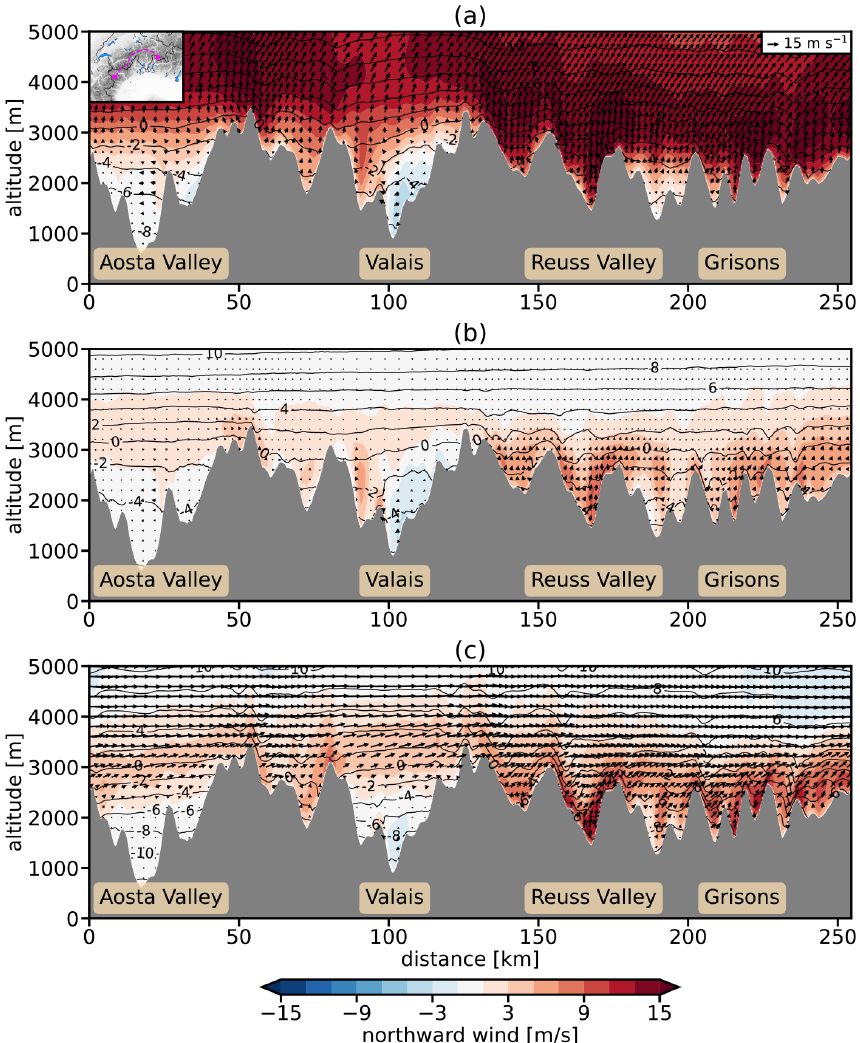
Figure 5. Same as Fig. 4a–c but along the crest line as defined in Sect. 2.2. The colours indicate the northward component of the wind and the arrows the horizontal wind field. Arrows pointing to the right correspond to eastward winds and arrows pointing upward to northward winds. Major gaps along the crest line are labelled. (a) Deep foehn; (b) shallow foehn; (c) gegenstrom